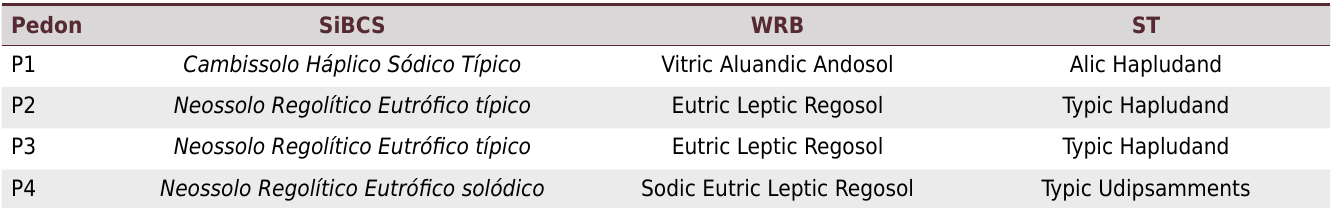
Table 6. Classification of TI soils according to SiBCS (2018), IUSS Working Group WRB (2015), and Soil Taxonomy (Soil Survey Staff, 2014), respectively